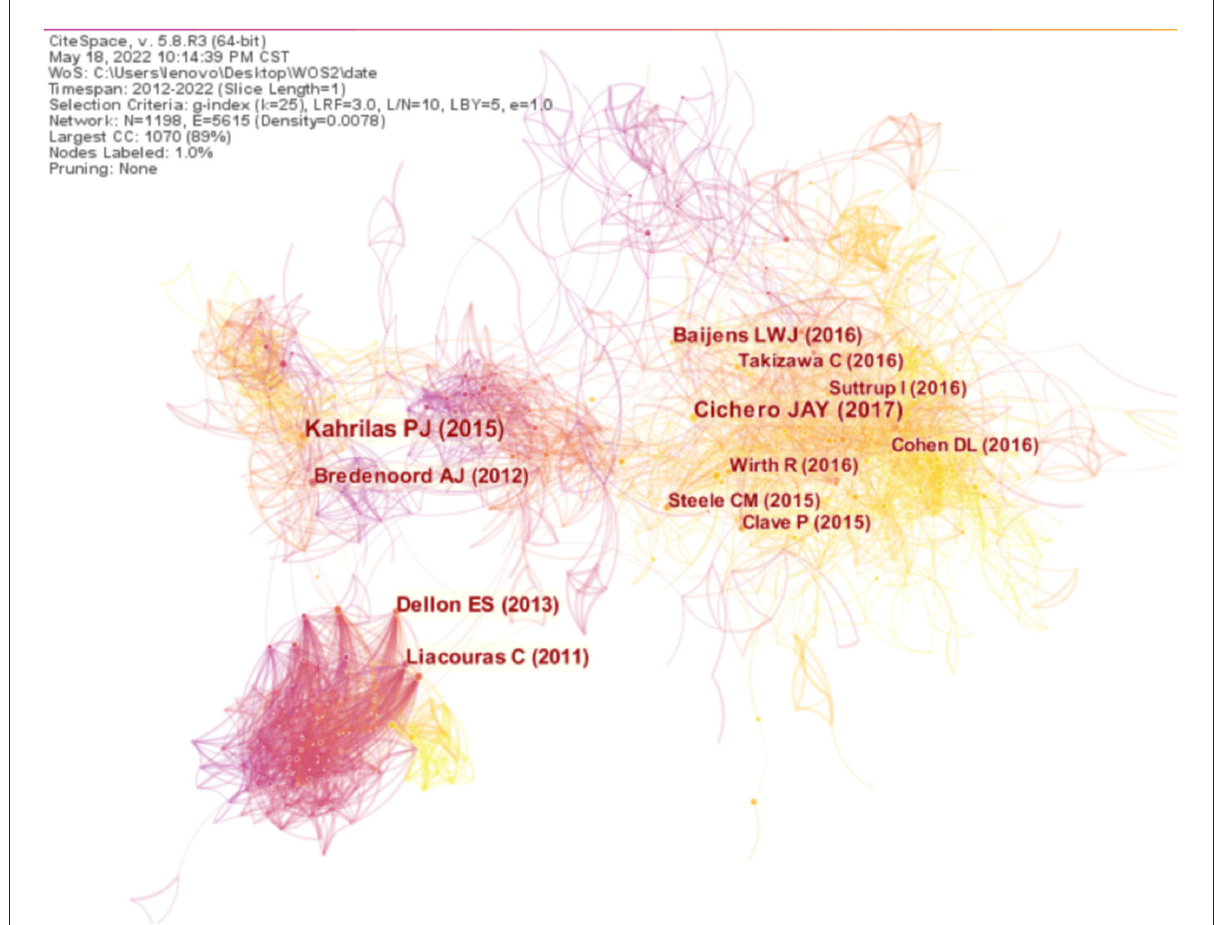
FIGURE8 Map of cited references distribution and cooperative relations on dysphagia from 2012 to 2022. The shorter the distance between the two circles, the more the cooperation between the two cited references.